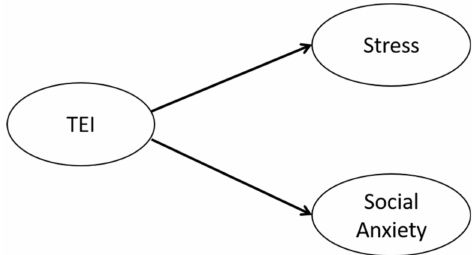
Figure 1. Hypothesized model. TEI—trait emotional intelligence.